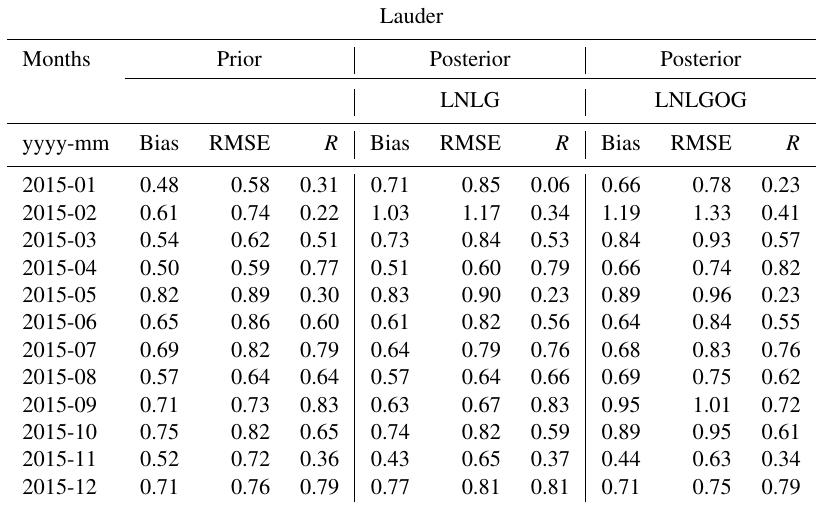
Table G4. Analysis of the residual between CMAQ prior and posterior simulations and the TCCON Lauder site for 2015: averaged bias, RMSE and Pearson’s coefficient ( R ).